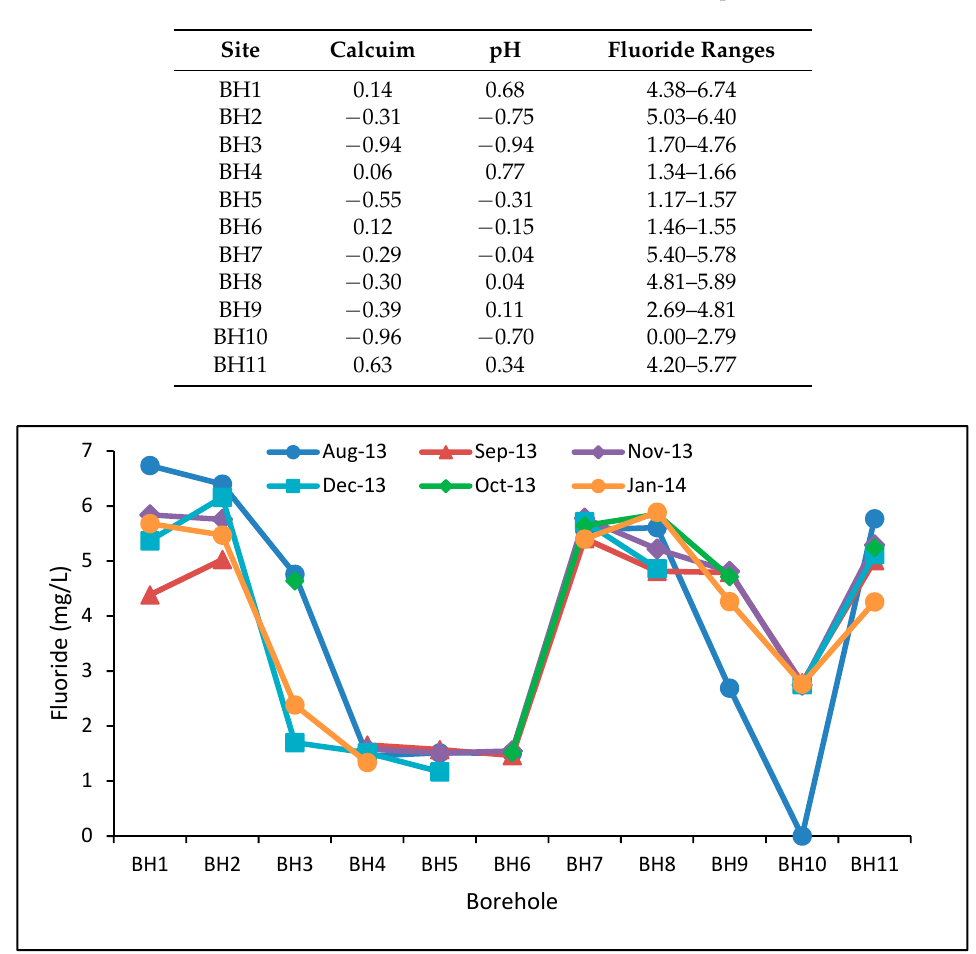
Figure 2. Variations of fluoride concentrations.